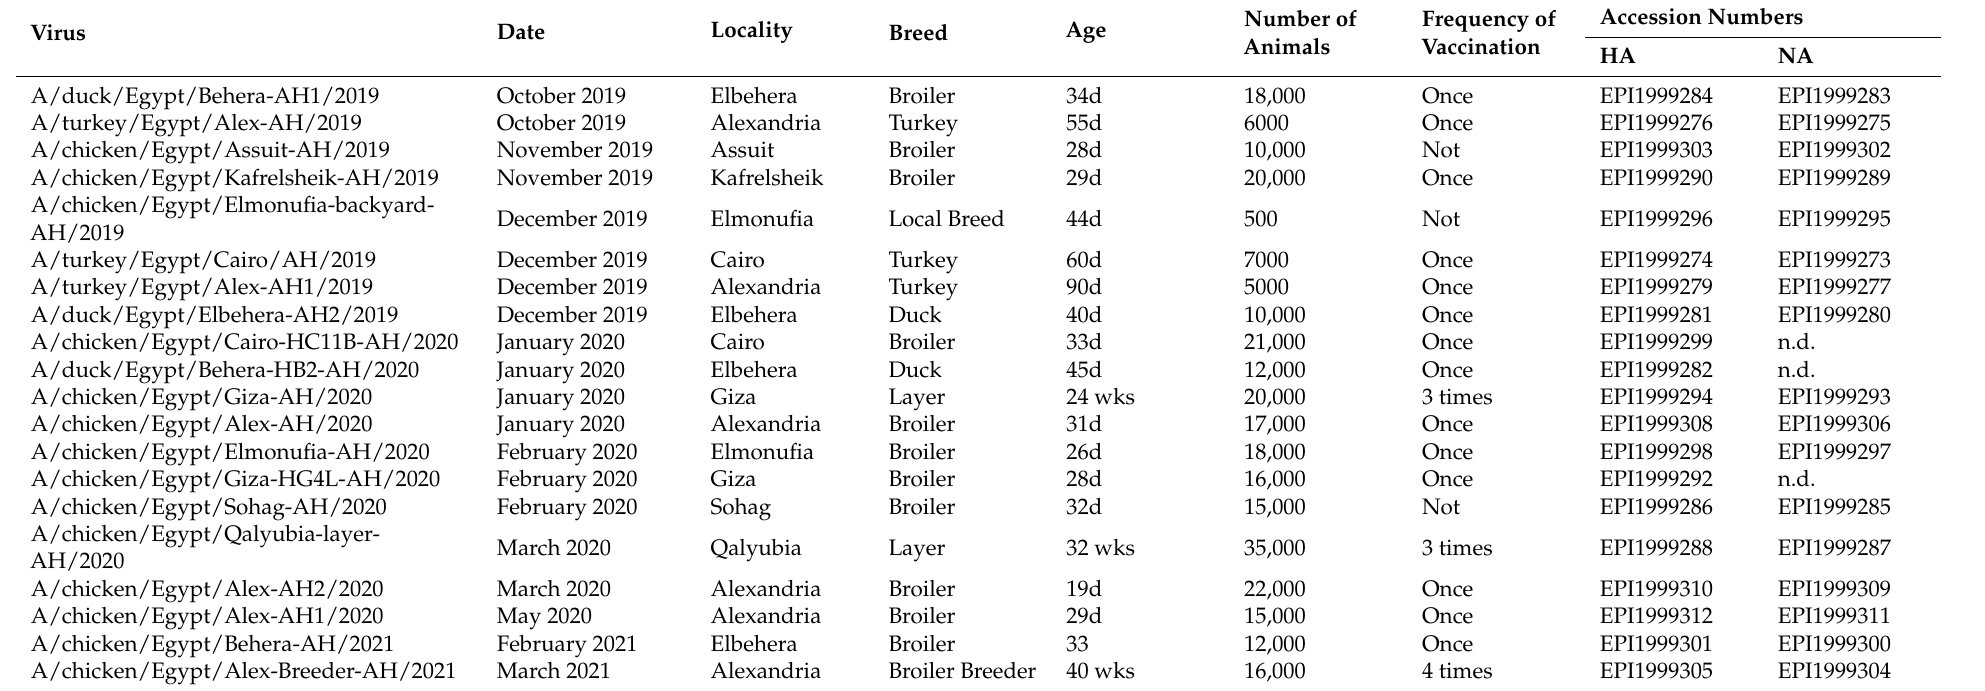
Table 1. H5N8 viruses isolated in this